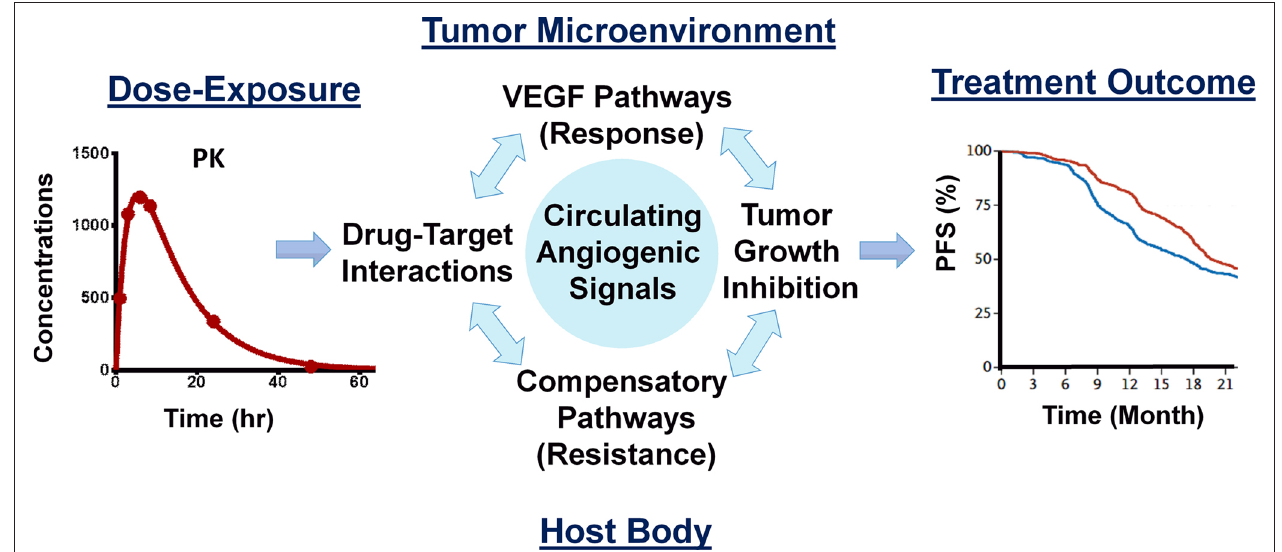
tumor cells, and therapeutic endpoints based on the drug’s response and compensatory mechanisms within a quantitative framework, to realize a bench to bedside